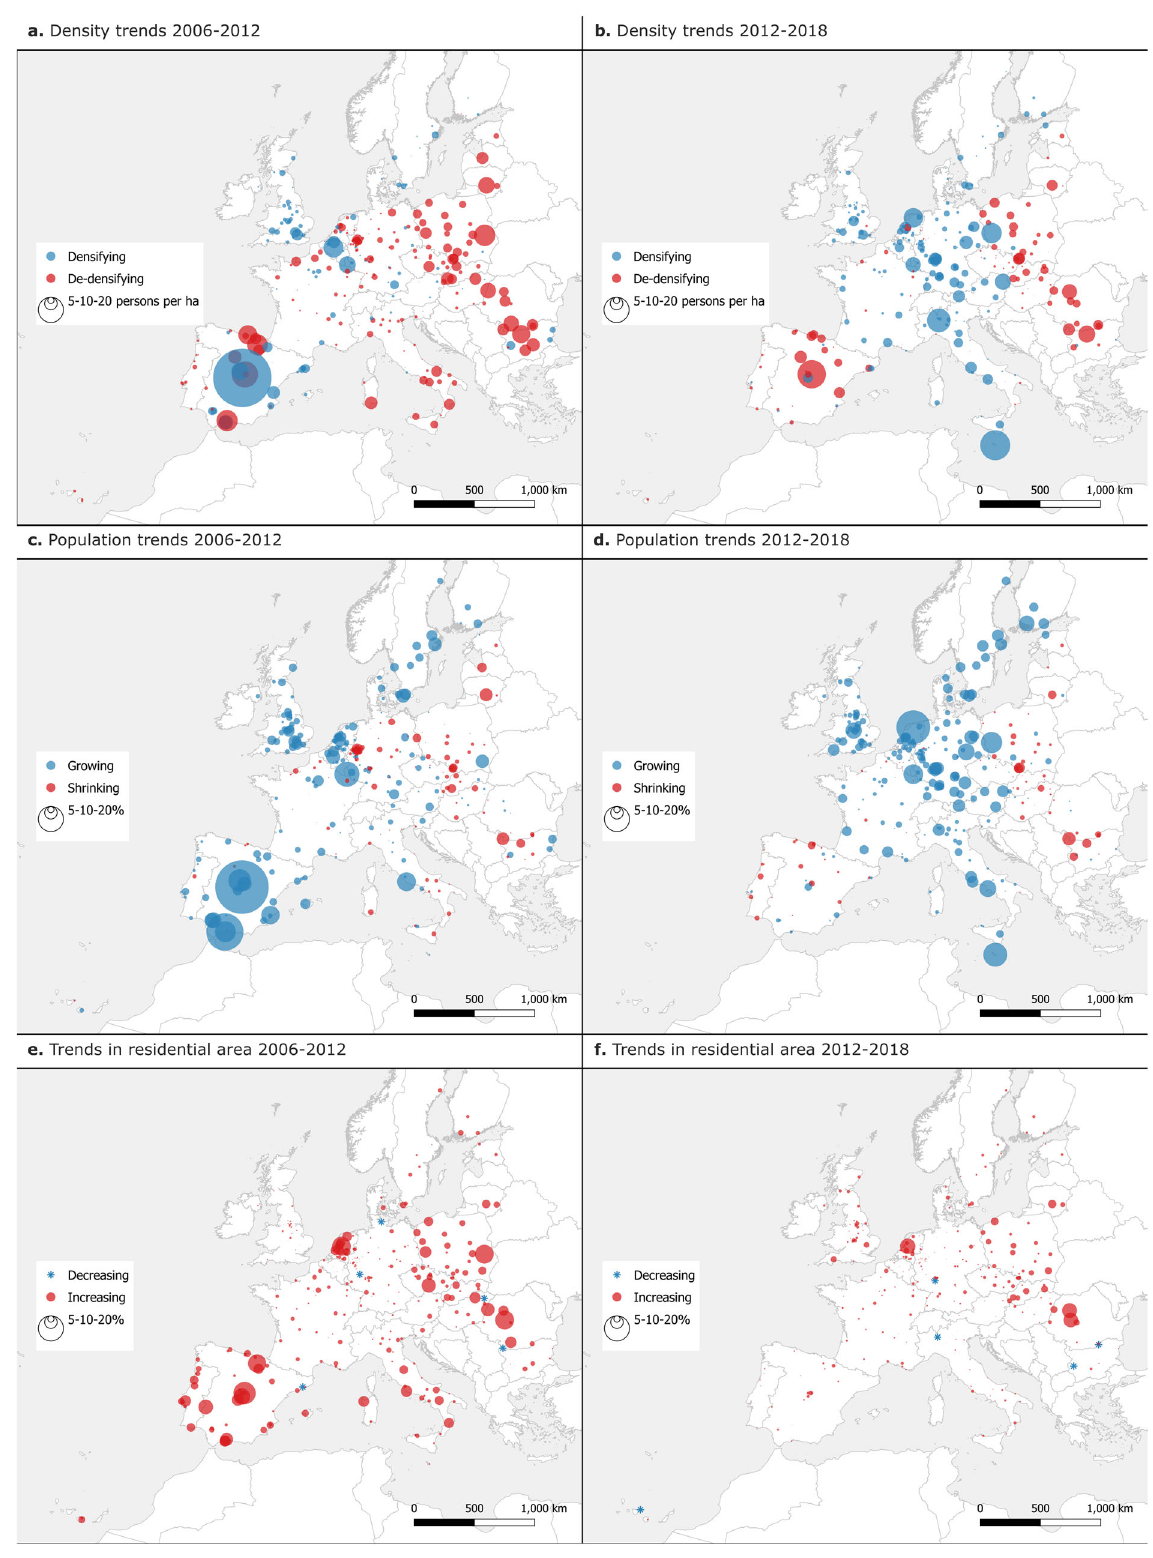
Fig. 2 Density trends and underlying trends in population and residential area. The maps show the contribution of the changes in population ( c , d ) and residential area ( e , f ) to the changes in the residential density ( a , b ) of the analyzed cities. Panels ( a ), ( c ), and ( e ) refer to the period 2006 – 2012; panels ( b ), ( d ), and ( f ) to the period 2012 –